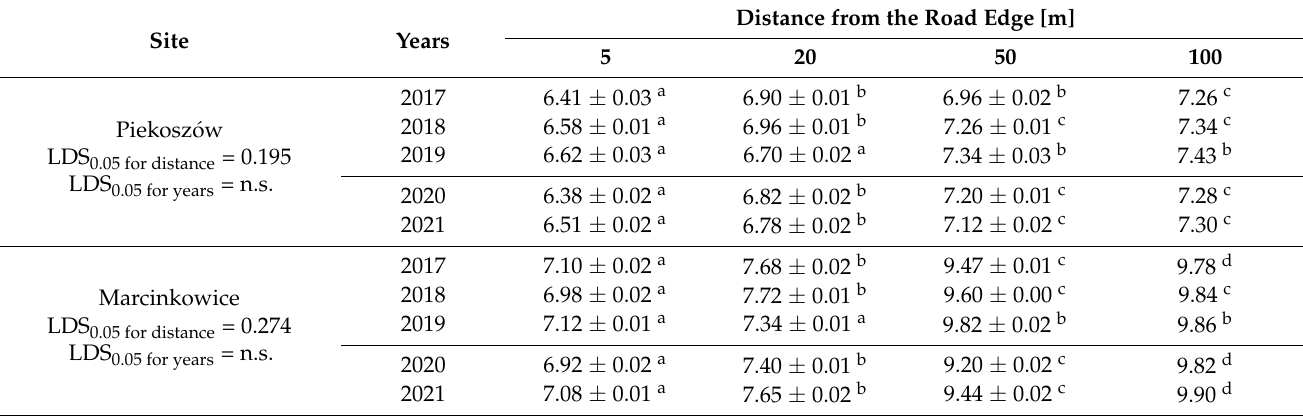
Table 4. Organic carbon content (TOC in g kg − 1 ) in soils before the COVID-19 pandemic (2017–2019) [28] and during the pandemic